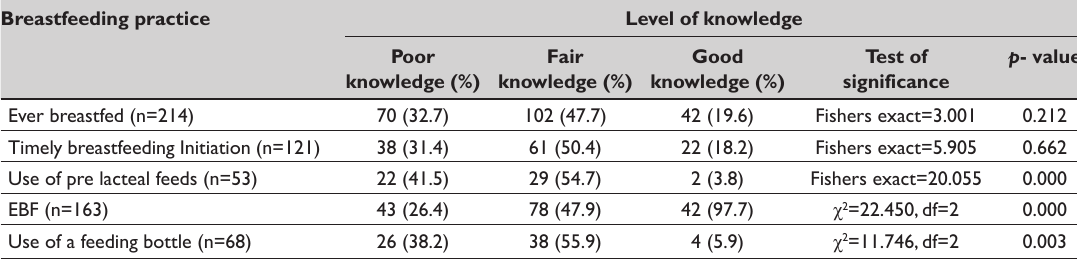
Table 4: Association between level of knowledge about breastfeeding and breastfeeding practices among mothers in the study Breastfeeding practice